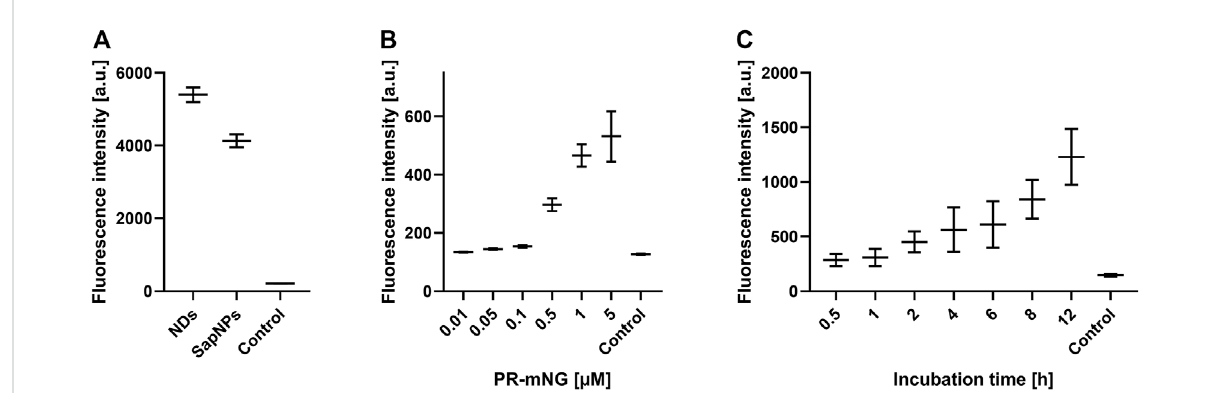
SapNPs as vector for MP transfer into HEK293T cells. PR-mNG/SapNP particles were prepared by CF expression of PR into preformed SapNPs (DOPG). The Strep-puri fi ed PR-mNG/SapNPs were incubated with HEK293T cells and the mNG fl uorescence in the cellular membrane was quanti fi ed. (A) Comparison of PR-mNG transfer from NDs (DOPG) and SapNPs (DOPG) at standard conditions. (B) Effect of PR-mNG/SapNP concentrationonPR-mNGtransfer. (C) EffectofincubationtimeonPR-mNGtransfer.Mean±SEMisshown.N=20cells.MP-freeNDs(DOPG) were used as a negative control.